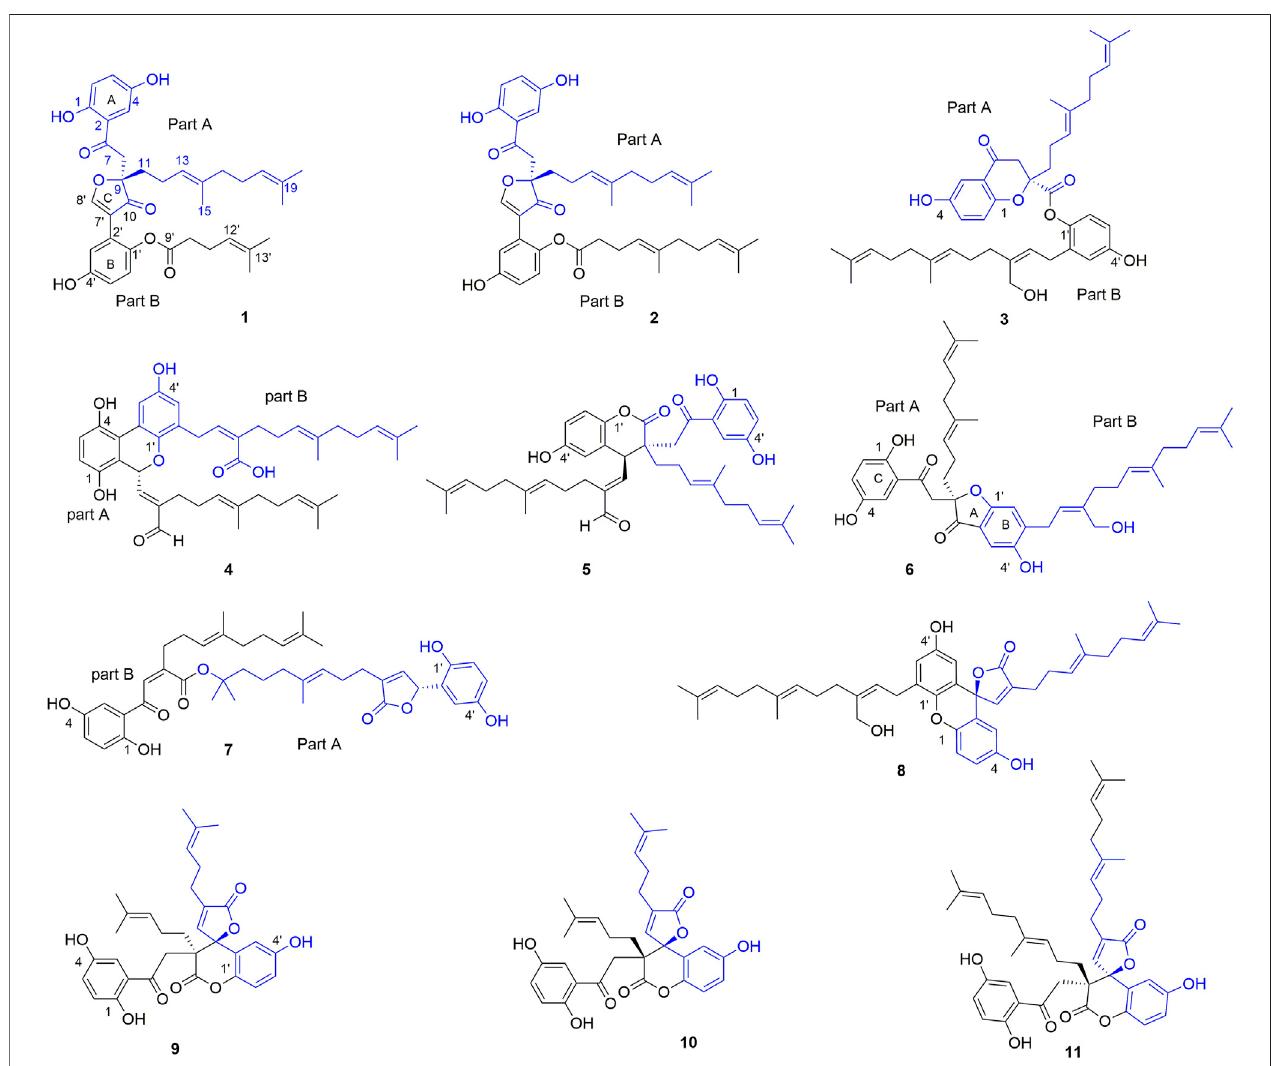
FIGURE 1 | The structures of 1 – 11